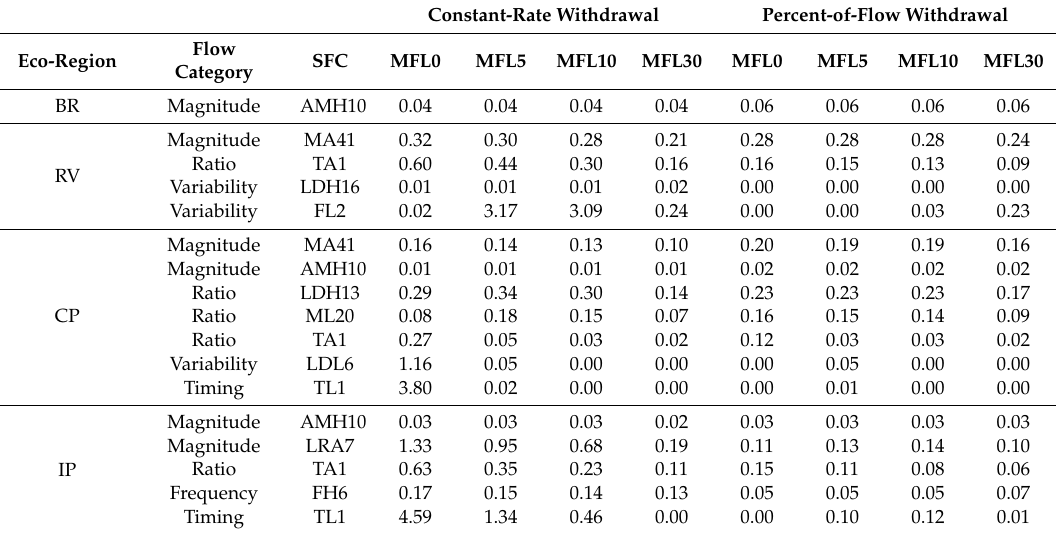
Table 2. Mean absolute change (i.e., sensitivity) of streamflow characteristics (SFC; standardized unitless values) across water-withdrawal scenarios and for each minimum flow level (MFL) under constant-rate and percent-of-flow withdrawals. MFLs represent low-flow protections set at 0, 5, 10, and 30% of mean annual flow. Constant-Rate Withdrawal Percent-of-Flow